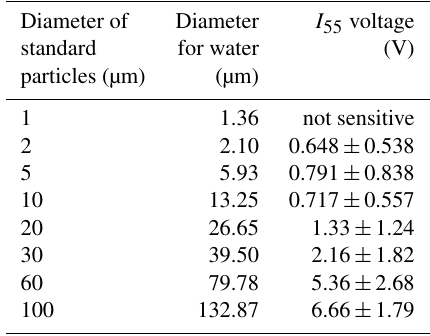
Table 3. Laboratory experiments to measure the CPS voltage for various standard particle sizes by Fujiwara et al.